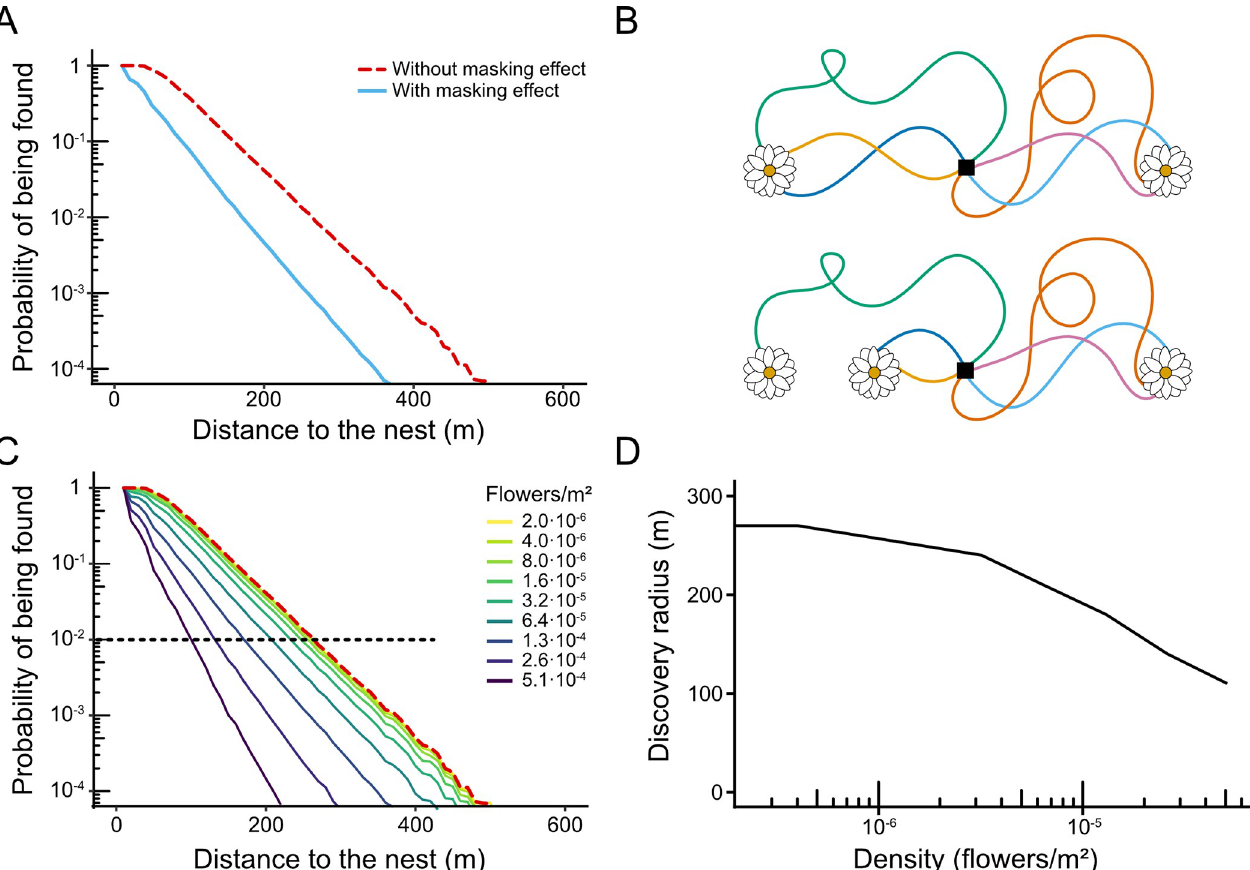
Fig 4. Probability that flowers are discovered. (A) Probability that a flower is found as a function of its distance to the nest. We simulated exploration trips in a field of uniformly distributed flowers with density 1.3 10 − 4 flowers/m 2 and flower size 70 cm. For each flower, we computed the probability that it was found in each exploration trip, and we show this probability as a function of the distance between the flower and the nest. Results were computed over 6000 simulated trips of 900s in 10000 environments for each density (negligible bar errors not reported). Red line: Probability calculated without taking into account the masking effect. Blue line: Probability calculated taking into account the masking effect (i.e., only counting the first flower that was discovered in each trip). (B) Illustration of the masking effect. The probability of discovering a flower depends on the presence of other flowers. In a scenario where there are just 2 flowers equidistant to the nest, both flowers should be visited equally (top). However, if another flower is added, it can capture visits that would otherwise visit one of the original flowers (bottom). Black square: nest. (C) Same as (A), but for different flower densities. Red dotted line: Probability calculated without taking into account the masking effect. This probability is independent of the density of flowers. Solid lines: Probability calculated taking the masking effect into account. Black dotted line: threshold probability at which we consider an area that has a high probability of being pollinated. (D) Radius of the area around the nest that has a high probability of being discovered (i.e., where the probability that flowers are discovered is above 10 − 2 ) as a function of flower